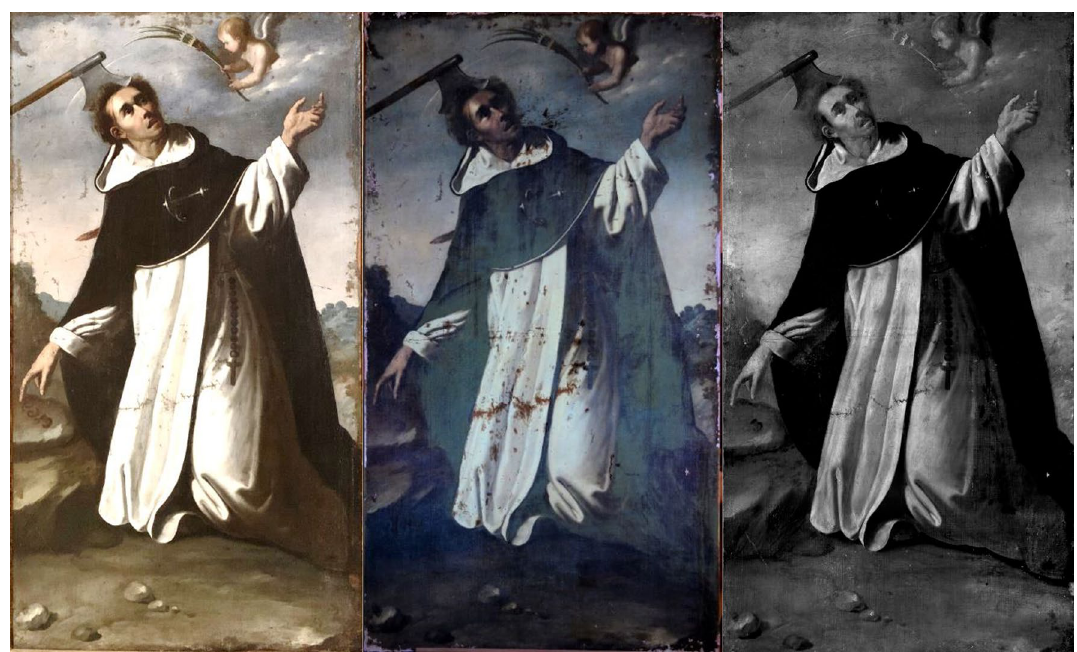
Figure 4. Painting of Saint Peter Martyr ( SP ) in visible (left), UV (centre), and IR (right)